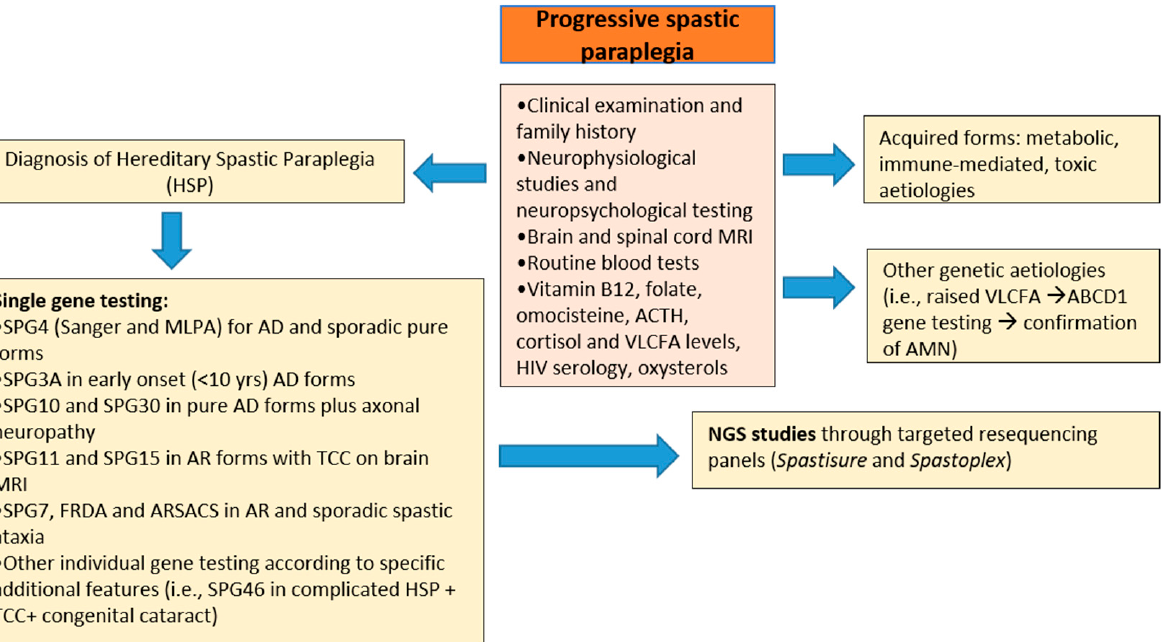
Figure 1. Diagnostic flowchart applied to patients with suspected degenerative progressive spastic paraplegia (HSP) Abbreviations: NGS, Next Generation Sequencing; VLCFA, Very Long Chain Fatty Acids; AD, autosomal dominant; AR, autosomal recessive; TCC, thin corpus callosum; FRDA, Freidreich’s Ataxia; ARSACS, Autosomal recessive spastic ataxia of Charlevoix-Saguenay; MLPA, Multiplex Ligation Probe Amplification; HIV, Human Immunodeficiency Virus; AMN, adrenomyeloneuropathy.